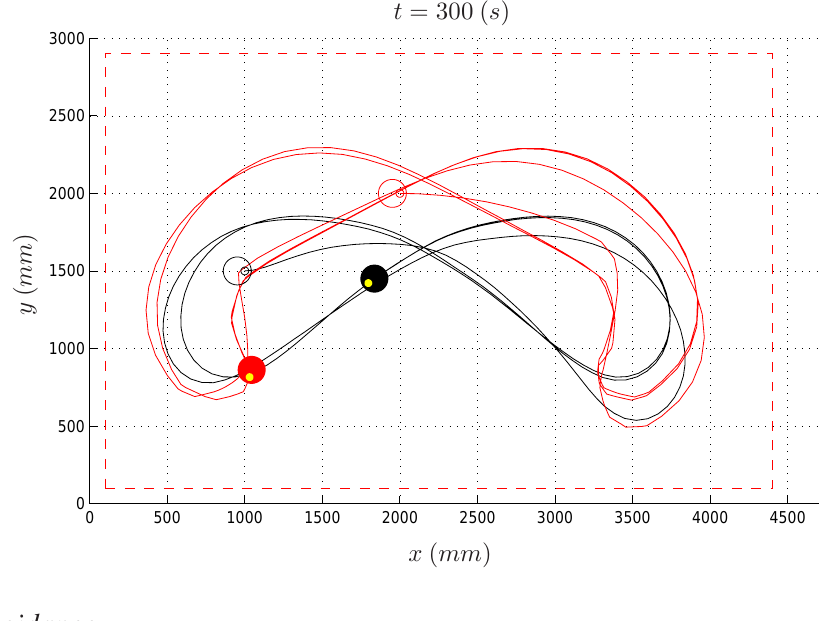
Figure 16. Pursuer-evader games, Algorithm 2: pursuer (black) and evader (red) with a PE speed ratio equal to 50% (simulated